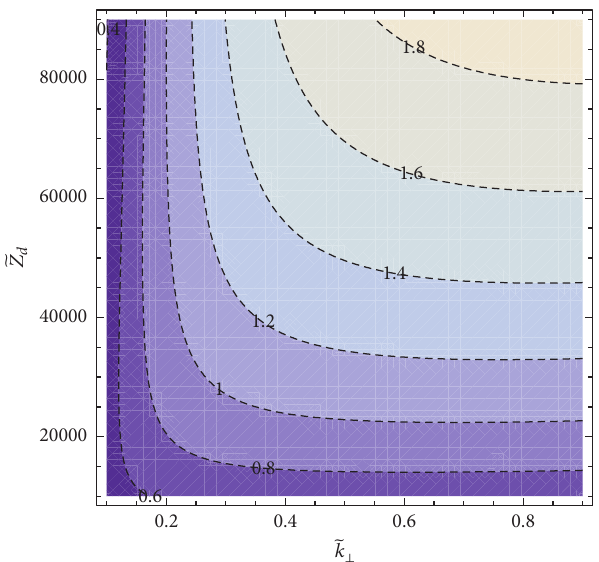
Figure 4: Effect of 𝑍 𝑑 on the dispersion characteristics.